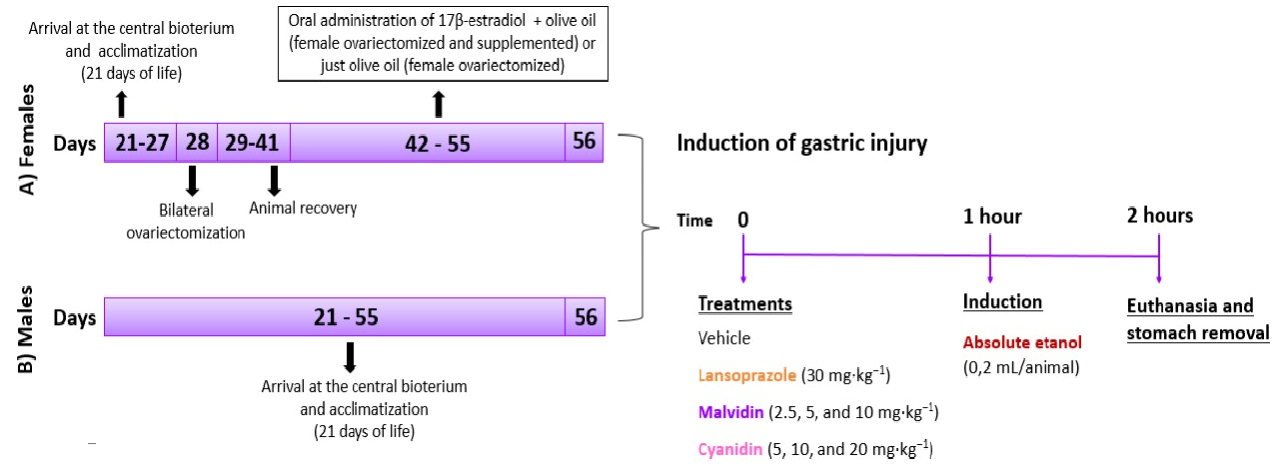
Figure 2. Schematic representation of the experimental protocol of the procedures performed in ( A ) female and ( B ) male mice.